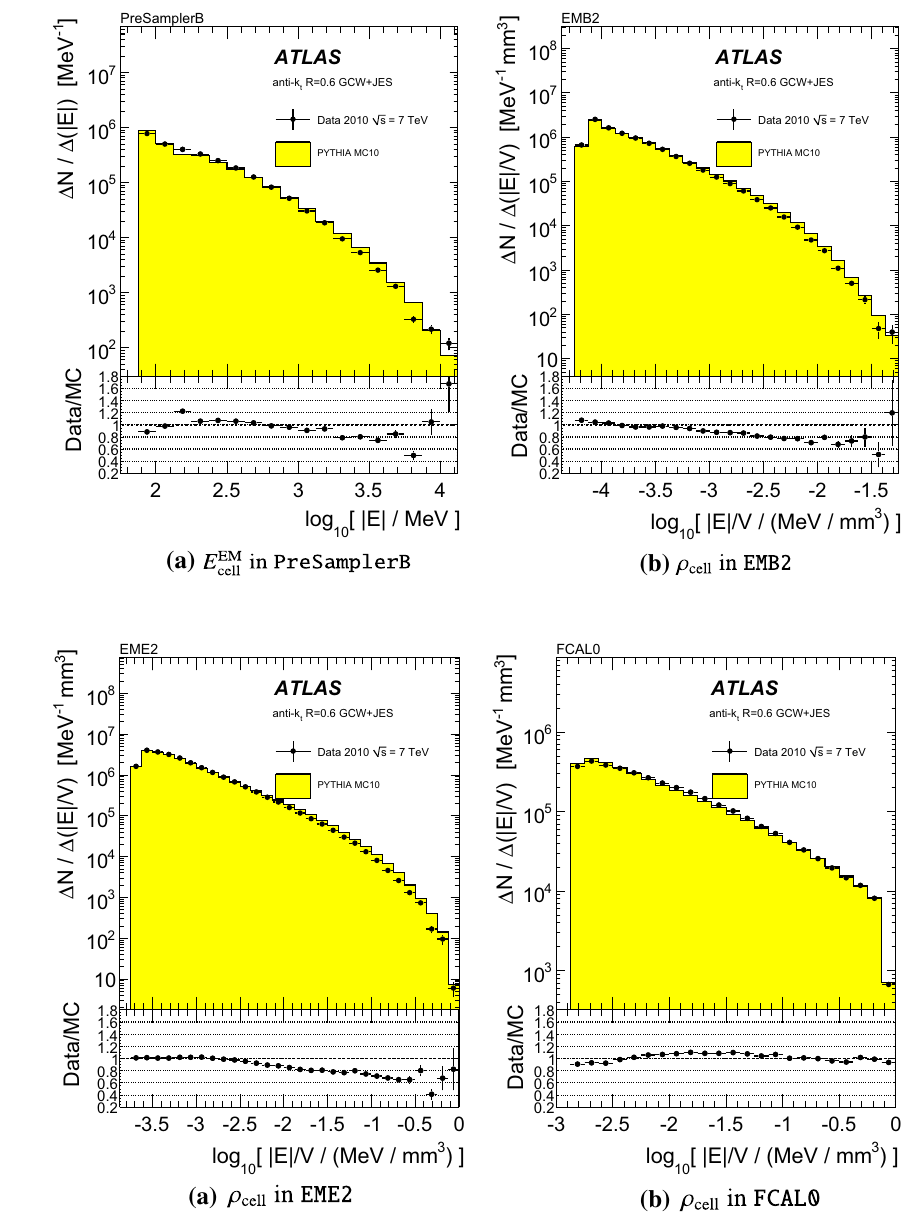
algorithmdefiningan out-of-clusterneighbourhood